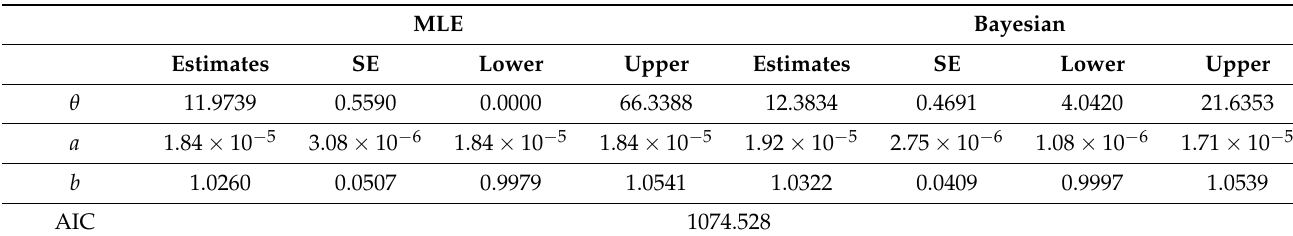
Table 8. MLEs and Bayesian estimates for parameters of progressive-stress model.